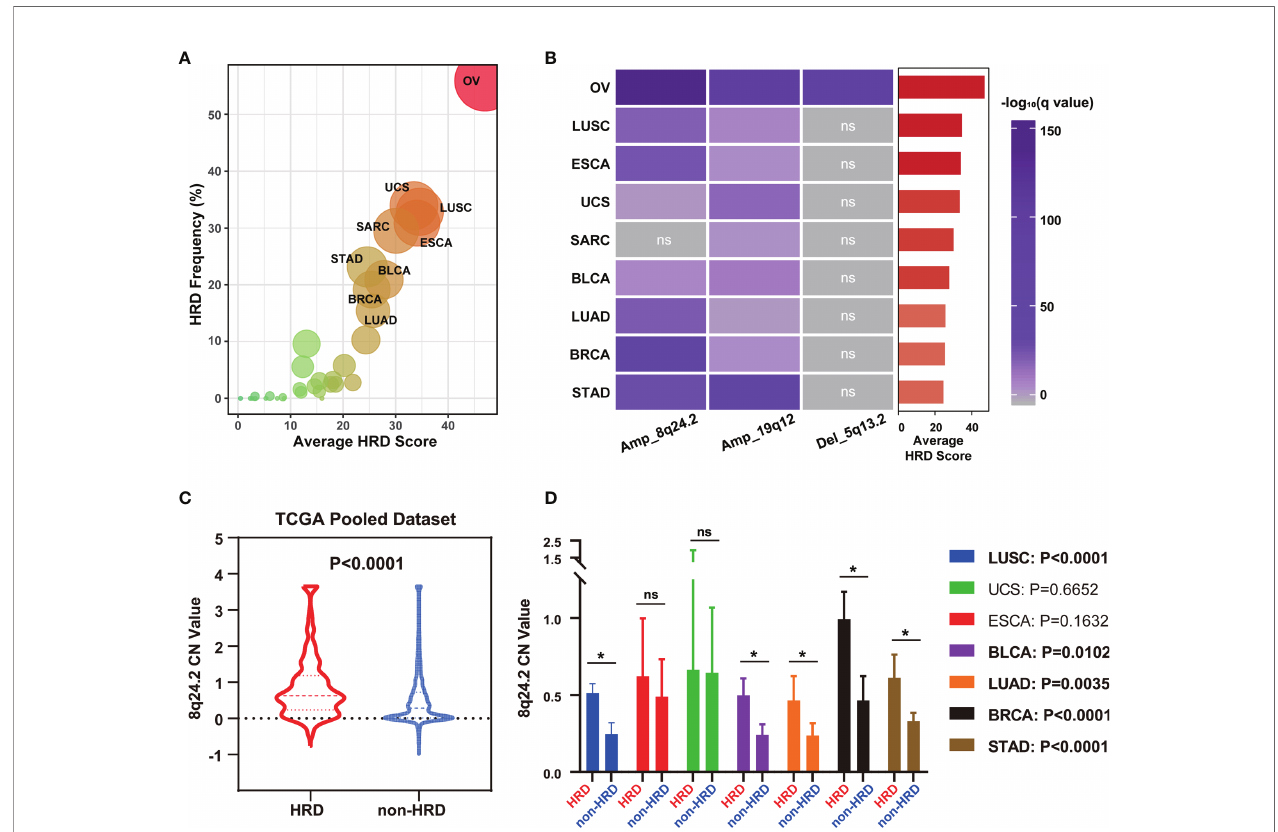
FIGURE 3 | 8q24.2 ampli fi cation for the prediction of HRD status in patients across cancer types. (A) The average HRD score and HRD frequency ( ≥ 42 as cutoff value) of 33 kinds of tumors in the TCGA dataset. (B) The CNV enrichment level of ampli fi cation of 8q24.2, 19q12, and deletion of 5q13.2 in nine kinds of tumors with the highest average HRD score. (C, D) According to HRD score, all tumor patients in TCGA were divided into an HRD group (HRD score ≥ 42) and a non-HRD group (HRD score < 42). (C) Violin plot of copy number value of 8q24.2 in the HRD group and the non-HRD group in all TCGA tumors. (D) Copy number value of 8q24.2 in the HRD group and the non-HRD group in 7 kinds of tumors. OV, ovarian serous cystadenocarcinoma. UCS, uterine carcinosarcoma. LUSC, lung squamous cell carcinoma. SARC, sarcoma. ESCA, esophageal carcinoma. STAD, stomach adenocarcinoma. BLCA, bladder urothelial carcinoma. BRCA, breast invasive carcinoma. LUAD, lung adenocarcinoma. Statistical analysis was performed by Wilcoxon signed rank test in (C, D) NS, not signi fi cant, * p <